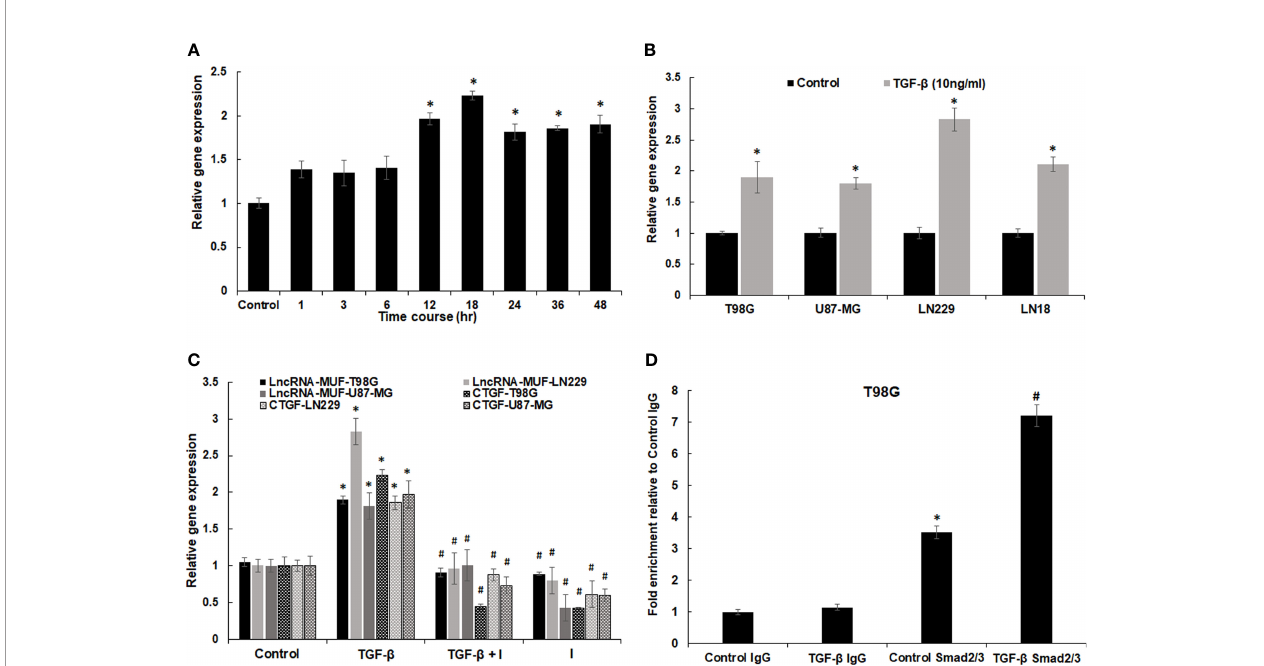
FIGURE 2 | Regulation of lncRNA-MUF expression through Smad2/3 signaling. (A) LncRNA-MUF is a delayed transcript with induction of ~2-fold at 12 and 18 h of TGF- b 1 treatment (10 ng/ml), then reaching a plateau of ~1.8-fold at 24, 36, and 48 h. RNA levels were measured at the indicated time points using qRT-PCR. (B) LncRNA- MUF induction upon TGF- b treatment is not cell type-speci fi c. The indicated GBM cell lines were treated with 10 ng/ml TGF- b for 24 h and lncRNA-MUF levels measured by qRT-PCR. (C) LncRNA-MUF induction upon TGF- b treatment is smad2/3 dependent. Human glioma cells (T98G, LN229, and U87-MG) were pretreated with 6 µM of SB505124 (TGF b R1/Smad2/3 inhibitor) for 2 h followed by co-treatment with TGF- b 1 (10 ng/ml) for 24 h, and lncRNA-MUF transcript levels were determined by qRT-PCR. (D) ChIP-qPCR analysis of smad2/3 interaction with SBE in the lncRNA-MUF promoter in control and TGF- b -treated T98G cells. DNA was isolated from control and TGF- b -treated cells after immunoprecipitation with the anti-smad2/3 antibody and was ampli fi ed using speci fi c primer sets. LncRNA-MUF promoter levels in immunoprecipitated samples were measured by qRT-PCR analysis, normalized to input, and represented as “ fold enrichment relative to control IgG I.P. ” Values represent mean ± S.D. from two independent experiments. *Signi fi cant change compared to IgG (p < 0.05). #Signi fi cant change compared to control Smad2/3 (p < 0.05). Data information: RNA samples were analyzed by quantitative RT-PCR, normalized with TBP/HPRT. Error bars represent the mean ± SEM from 3 independent experiments. *Signi fi cant change compared to respective control samples (p < 0.05). # Signi fi cant decrease from TGF- b -treated cells (p < 0.05). Statistical comparisons were made using Student ’ s